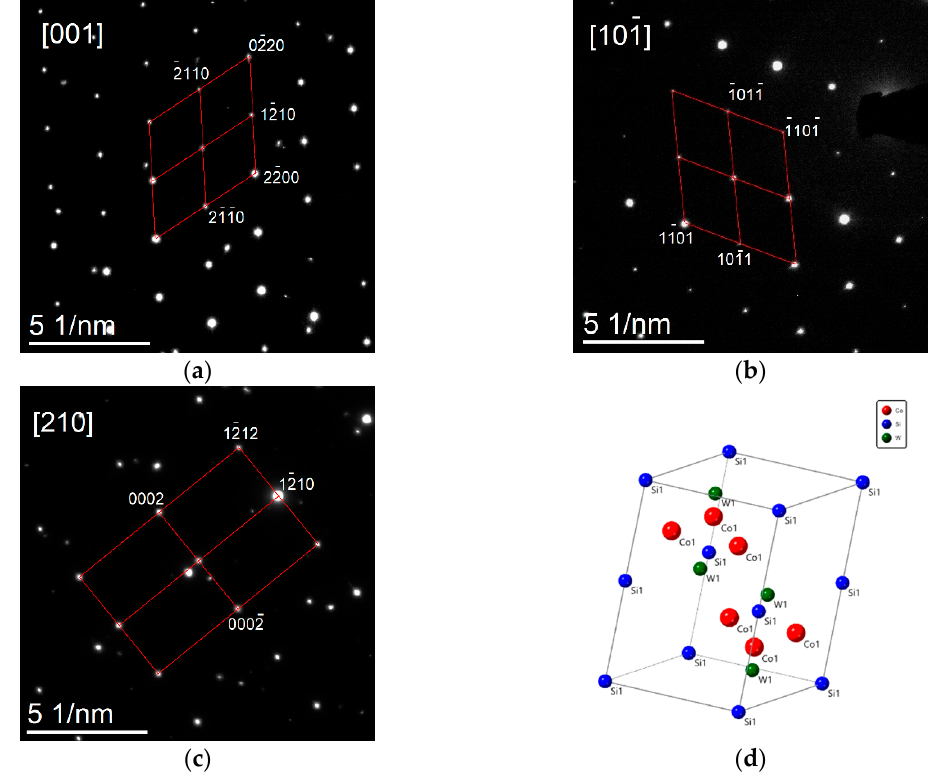
Figure 6. SAED electron diffraction of Co 3 (Mo,W) 2 Si in the direction ( a ) [001]; ( b ) [10 − 1]; and ( c ) [210]. ( d ) Model of Co 3 W 2 Si unit cell.